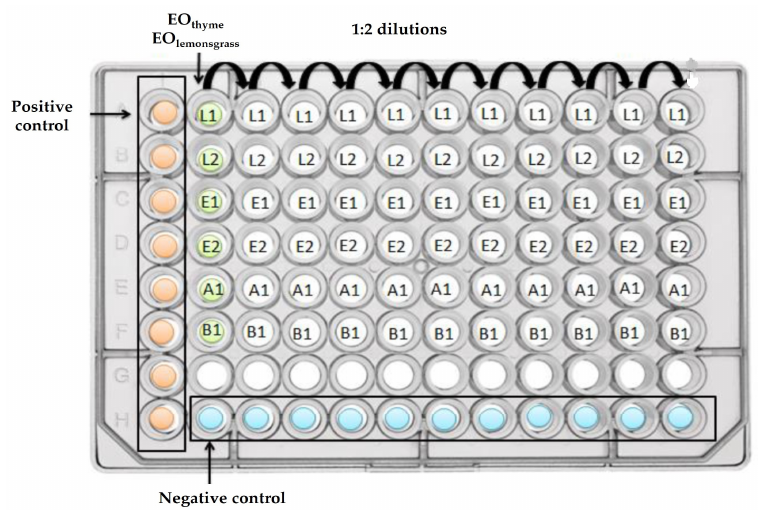
Figure 3. Schematic organization of the polystyrene 96-well microtiter plates used for pure cultures, incubated with EOs in 1:2 ( v / v ) dilutions. B1— B. thermosphacta ATCC 11509 T ; A1— A. hydrophila A259; E1— E. faecalis QSE123; E2— E. faecalis V583; L1— L. monocytogenes CECT 937; L2— L. monocytogenes CECT 935. Note 1: Positive control contained BHI broth inoculated with the correspondent bacteria. Note 2: Negative control contained only BHI broth.